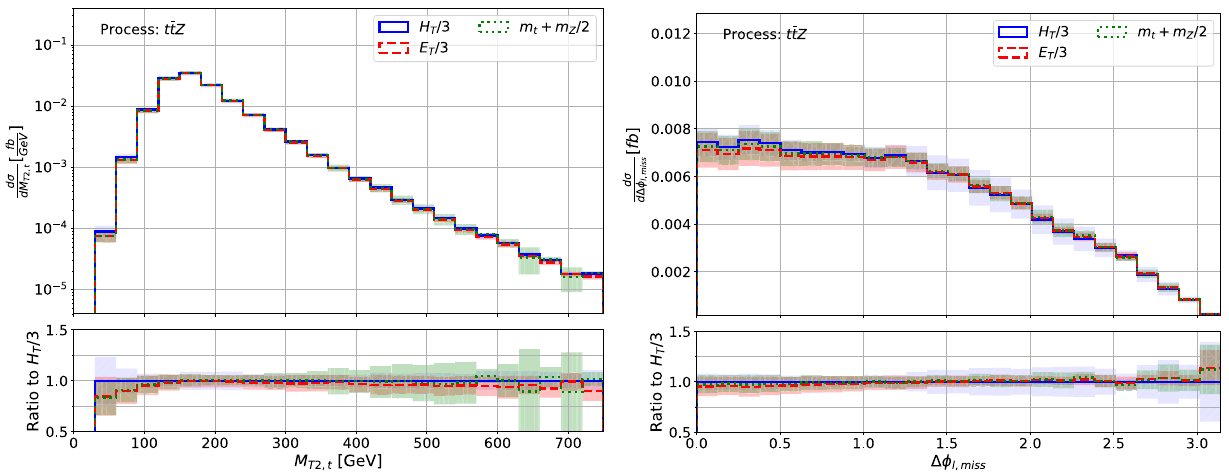
√ s = 13 TeV. The error bands depict the respec- center of mass energy tive scale uncertainties. In the lower panels we present the ratios to our default scale choice H T /